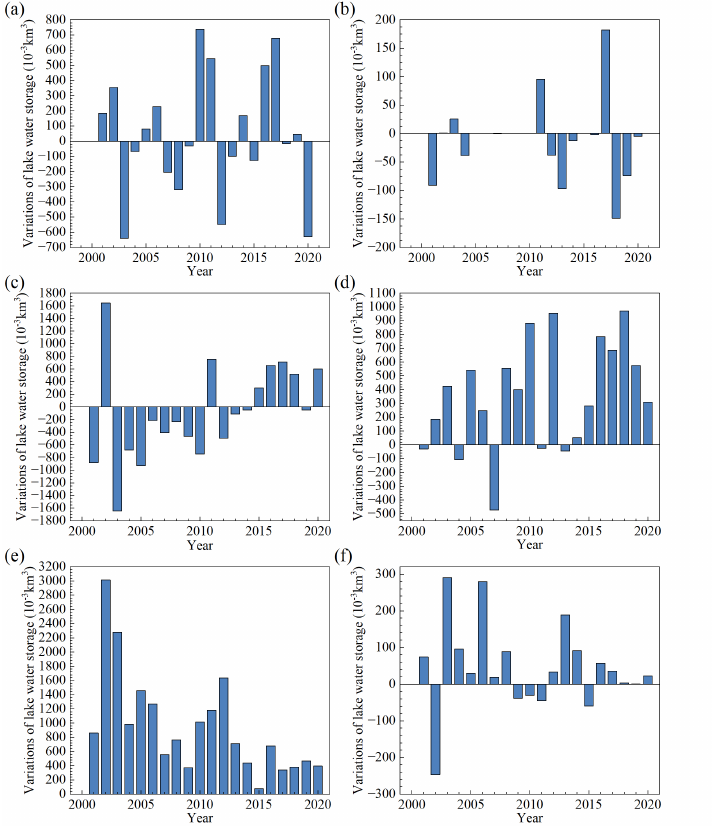
Figure 5. Annual variation of lake storages in 2000–2020 ( a ) Ulungur Lake; ( b ) Manas Lake; ( c ) Bosten Lake; ( d ) Ayakkum Lake; ( e ) Aqqikkol Lake; ( f ) Aksayquin